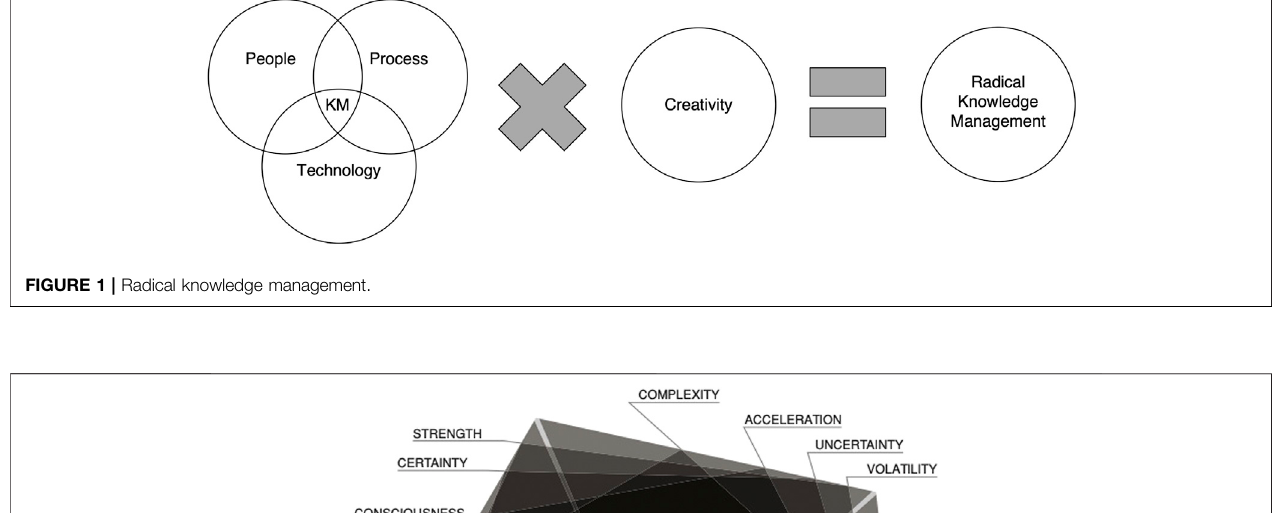
Frontiers in Arti fi cial Intelligence |